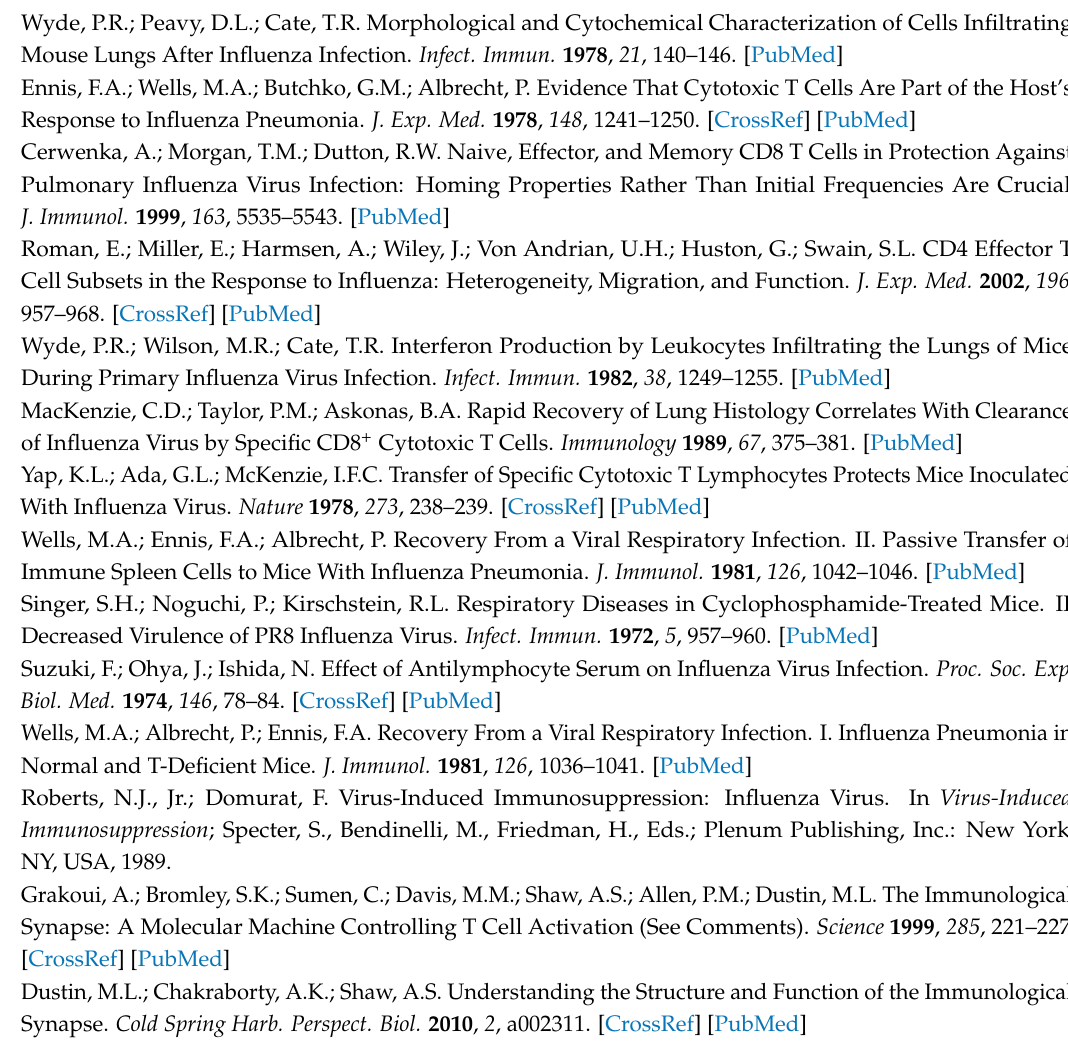
Figure S1: Purity of lymphocyte populations after separation procedures. Figure S2: Purity of T-lymphocyte subpopulations after separation procedures. Figure S3: Protocol for stimulation, exposure to virus, and collection and analysis of small, resting lymphocytes and large, proliferating